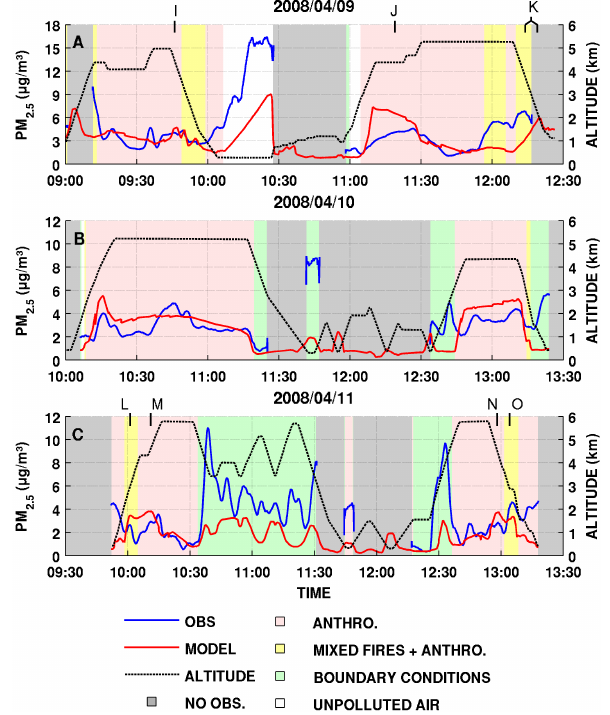
Figure 7. Time series of PM 2 . 5 measured during POLARCAT- France (blue) and modeled (red) with the aircraft altitude in- dicated in black for the three POLARCAT-France flights on (a) 9 April 2008, (b) 10 April 2008, and (c) 11 April 2008. Grey shading indicates times when no measurements are available. Col- ors indicate when PM 2 . 5 was significantly influenced ( > 20% of PM 2 . 5 ) by source: green shows air entering the domain from the northern boundary conditions, pink shows anthropogenic emissions within the domain, yellow shows fire emissions within the domain, and white shows unpolluted air (free of recent pollution sources). Letter labels indicate anthropogenic (I, J, M, N) and mixed anthro- pogenic/fire (K, L, O) plumes investigated